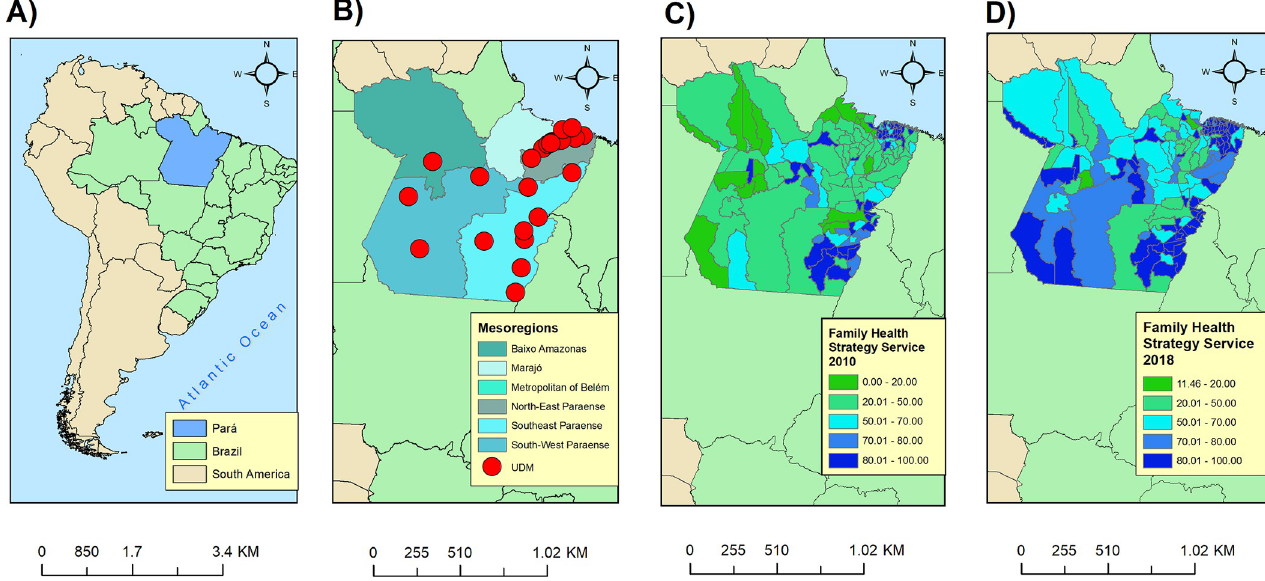
Fig 1. Location map of the study setting, State of Para´, Brazil. (A) Map of the South American continent. Brazil is highlighted in green and Para´ in blue; (B) Mesoregions of Para´ and punctual spatial location of the Medications Dispensing Units; (C) The Family Health Strategy Services coverage in all municipalities of Para´ in 2010, and (D) in 2018. Source: